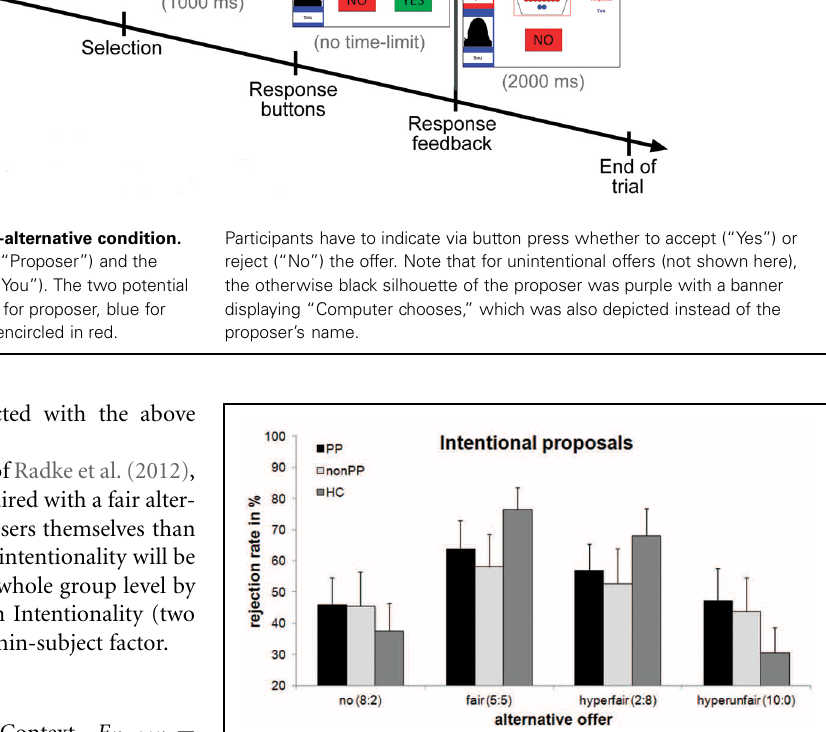
FIGURE 2 | Rejection rates of intentional unfair offers with regard to alternative offers and group. Mean percentage and standard errors of rejection of 8:2-offers are displayed. PP, offenders with psychopathy; non-PP, offenders without psychopathy; HC, healthy controls.